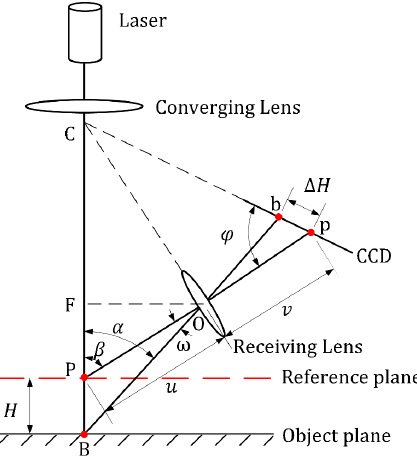
Figure 1. A schematic diagram of a typical direct laser triangulation.